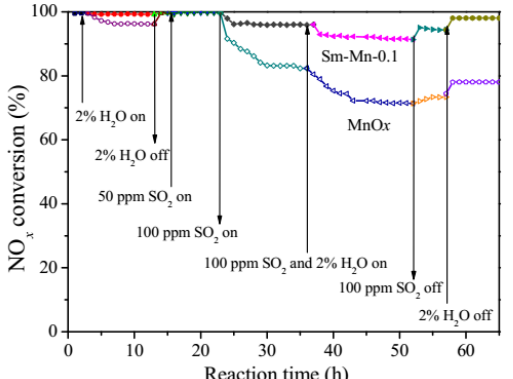
Figure 11. The effect of H 2 O and SO 2 on the catalytic activities of the MnO x and Sm–Mn ‐ 0.1 catalysts for the SCR reaction at 100 °C (Reaction conditions: 0.3 g catalyst, 500 ppm NO, 500 ppm NH 3 , 5% O 2 , Ar to balance, GHSV = 49,000h − 1 ). (Reproduced with permission from Reference [33], Copyright 2016, American Chemical Society.).